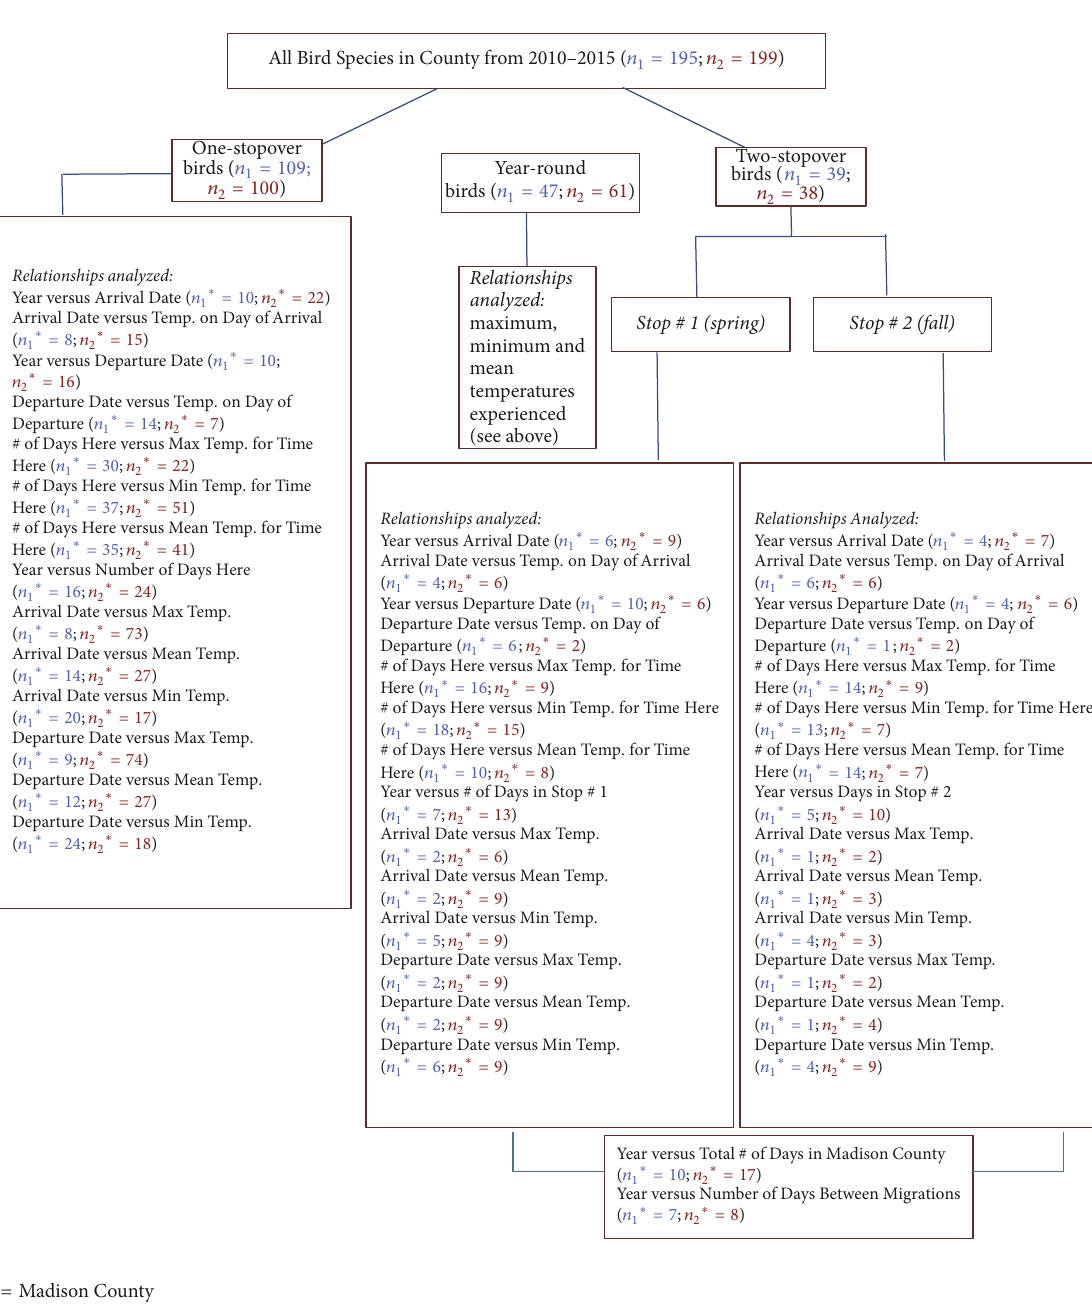
Figure 1: Graphical depiction of our experimental design including two New York State areas, each of which have bird species that were classified into resident, one stopover, or two stopover. After classifying each species, we looked at different correlations between migration timing, stopover timing, and relationships therein correlated with historical temperatures in the